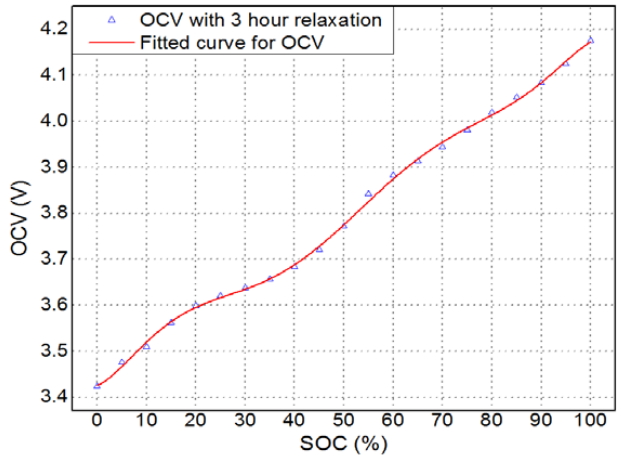
Figure 2. Relationship between open circuit voltage (OCV) and state of charge (SOC) in the lithium-ion battery cell.